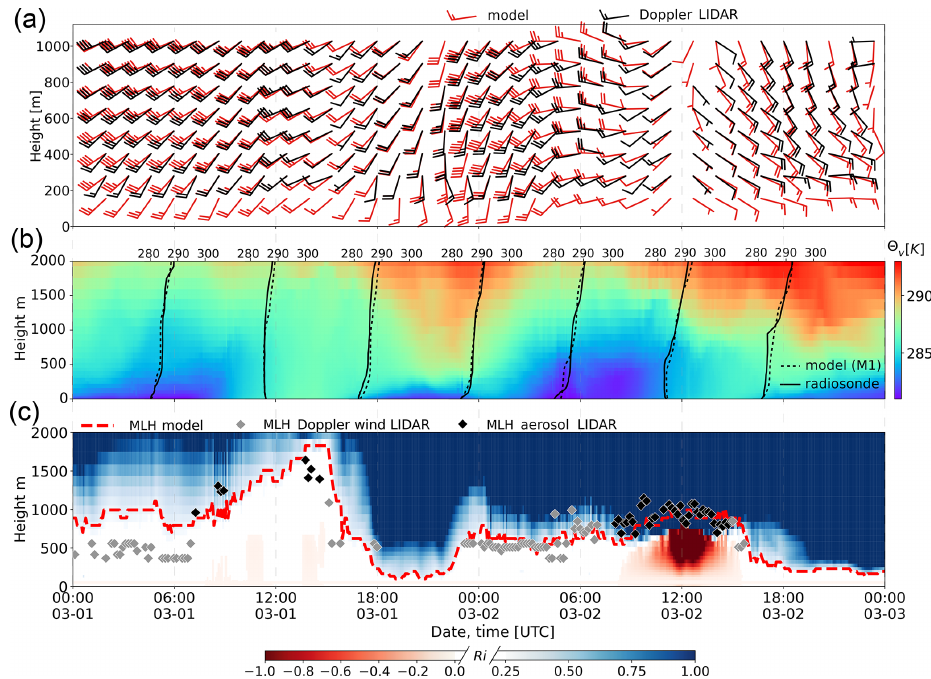
Figure 11. Overview of the PBL structure during the simulation period based on model and observational data (listed in Sect. 2.2). Unless mentioned otherwise, data are representative for the TROPOS site and model data are from simulation M3. In (a) , vertical profiles of the horizontal wind derived from measurements with the Doppler wind lidar (black barbs) are compared to interpolated modeled profiles (red barbs). The temporal averaging period of the depicted data is 20min. In (b) the vertical distribution of modeled virtual potential temperature (cid:50) v is shown by the area plot. It is supplemented with 6-hourly (cid:50) v profiles from atmospheric soundings at the meteorological sites Lindenberg and Meiningen (station average, full black lines), and comparable model output from domain M1 (black dotted lines). Panel (c) shows the simulated MLH (red dashed line), which is based on a combination of the bulk-Richardson number Ri (area plot) and the parcel method. Respective MLH retrievals from the wind lidar are shown by the gray diamonds, while the black diamonds show the MLH retrievals based on data from the aerosol lidar Polly XT.